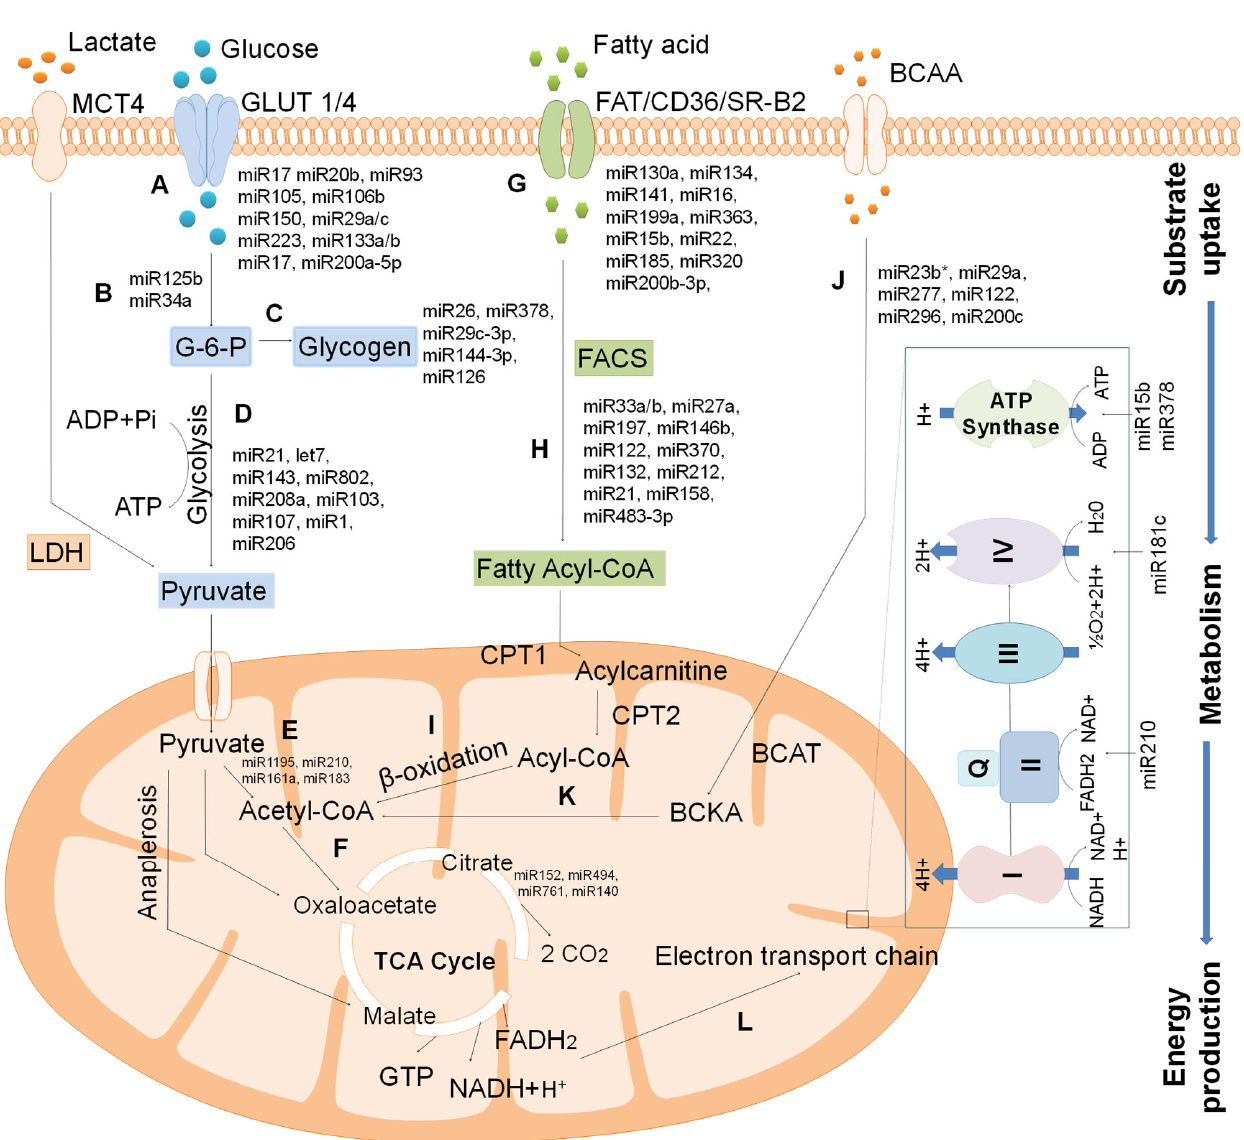
Figure 1. Role of miRNAs in cardiac energy substrate metabolism. (A) miRNA-regulated glucose transportation into cardiomyocytes by GLUT1 or GLUT4. (B) miR-125b and miR34a regulates the hexokinase activity. (C) Glucose 6- phosphate undergoes glycogen synthesis under the regulation of miR26, miR378, miR29c-3p, miR144-3p, and miR126. (D) Glucose metabolism by glycolysis under the regulation of miRNAs. (E) The resulting pyruvate is converted to acetyl-CoA, and (F) enters into the TCA cycle to produce reducing equivalents. (G) Free fatty acids enter into the cardiomyocytes by miRNAs and form the fatty acyl- CoA (H) to be involved in β -oxidation to form acetyl-CoA (I). (J) BCAA was transported into mitochondria, oxidizing to form acetyl-CoA (K). (L) After the TCA cycle, the reducing equivalents undergo oxidative phosphorylation to generate chemical energy, ATP.